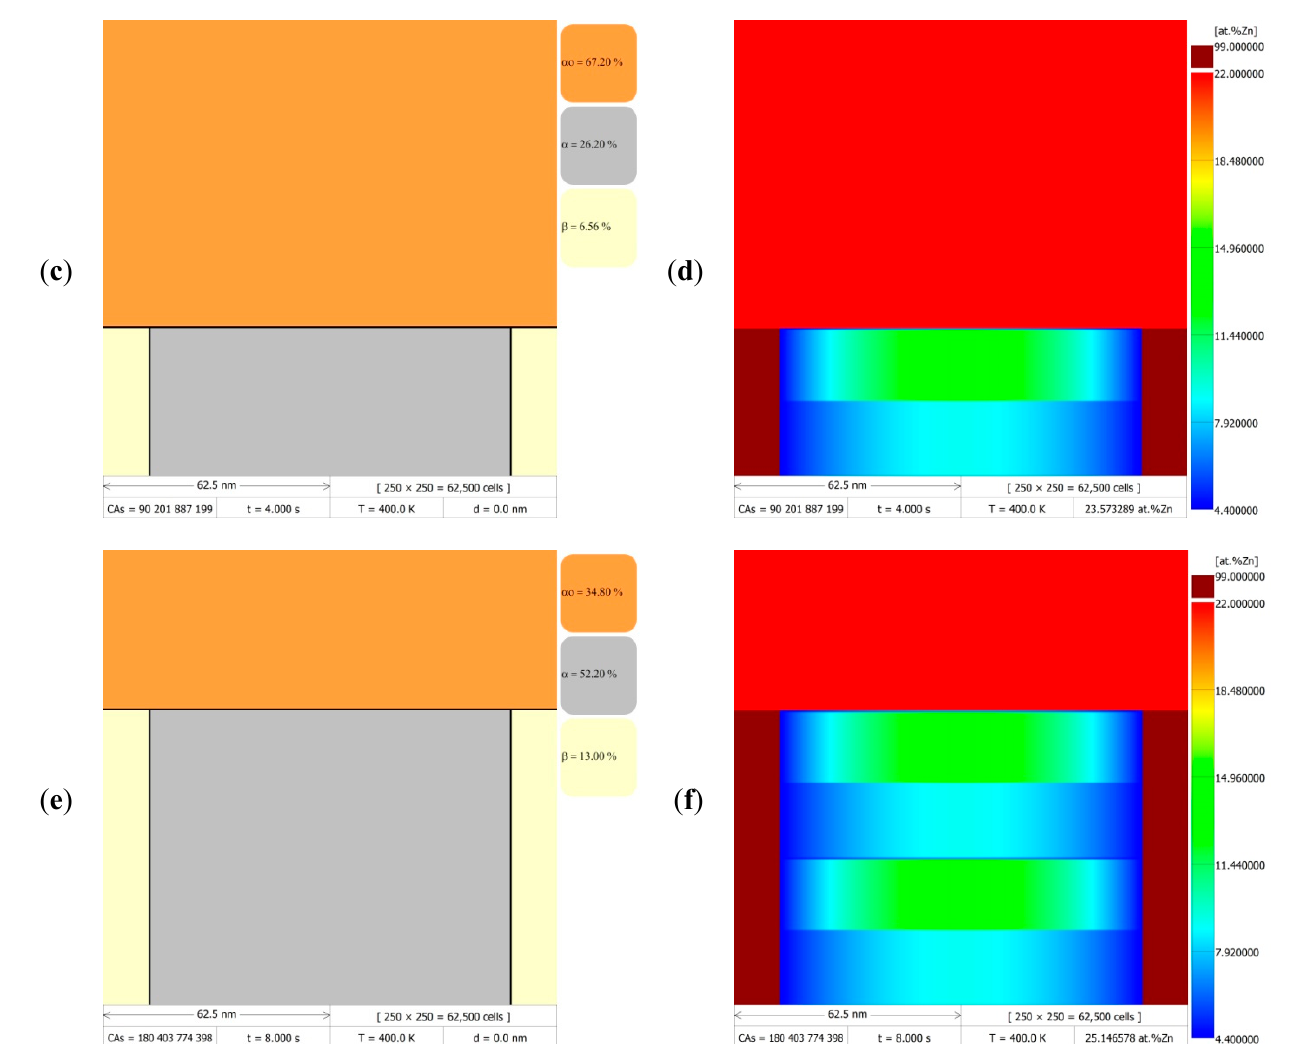
Figure 6. Simulation results in the form of DMR images (250 × 250 cell CA grid) with visible phases (left column) and maps with zinc redistribution (right column), which show the microstructure evolution and chemical composition changes during the DP reaction at 400 K (~127 °C), for a fixed RF migration velocity, 𝑣 = 20 nm/s, after time: 1 s ( a , b ); 4 s ( c , d ); and 8 s ( e , f ).